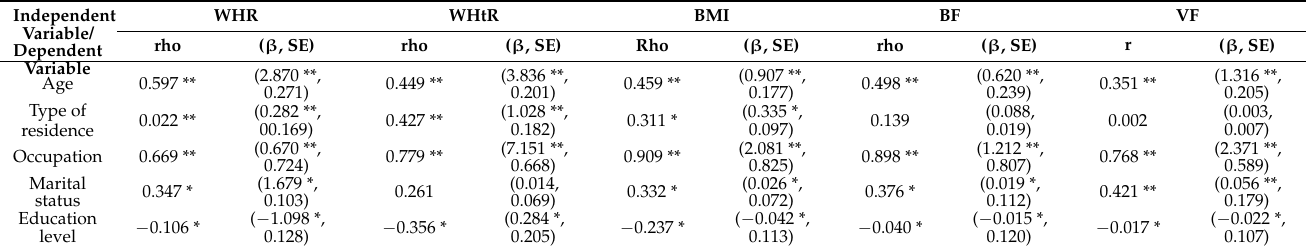
Table 5. Spearman correlation coefficients and simple linear regression analysis between demographic characteristics and waist-to-hip ratio, waist-to-height ratio, body mass index (BMI), body fat (BF), and visceral fat (VF) of females with CD ( n =